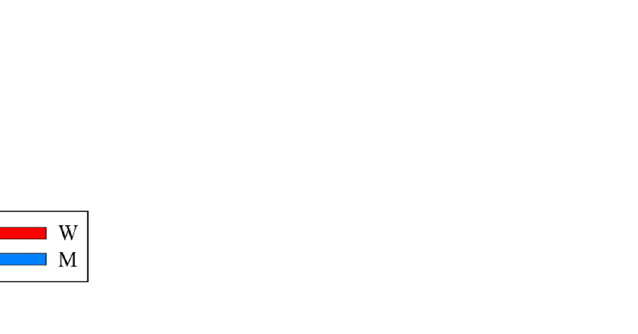
Figure 1. Results of the comparison of the perceived degree of stress, measured by the Visual Analogue Scale, between working men (M, blue bars) and women (W, red bars), with preschoolers (KID) and without